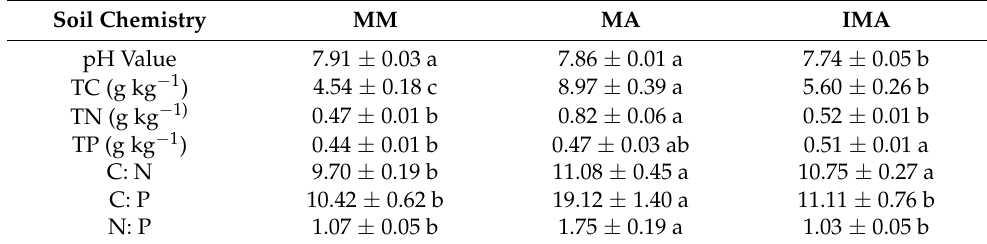
Table 1. C, N, P content and ecological stoichiometry in rhizosphere soils.